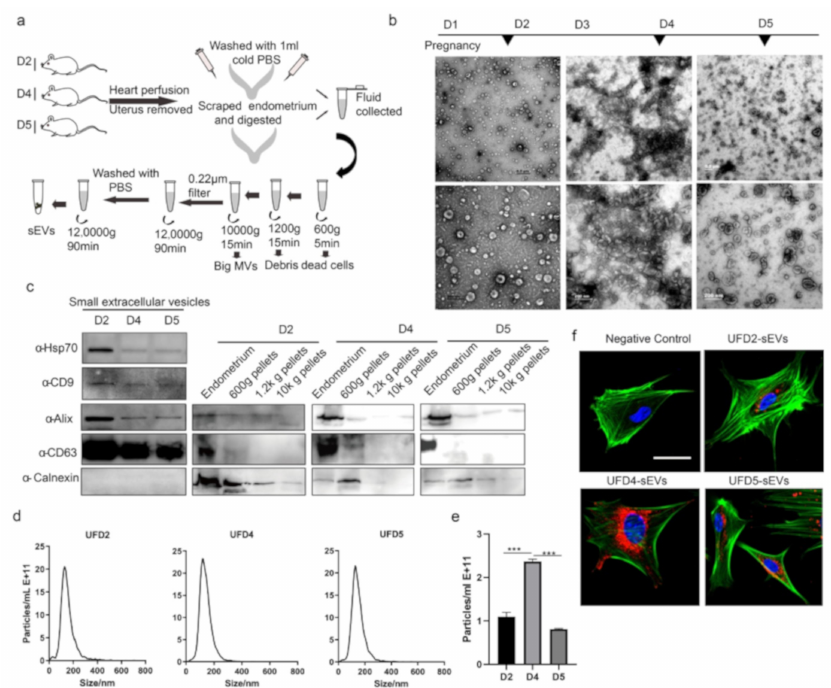
Figure 3. Identification of small extracellular vesicles (sEVs) derived from endometrium: ( a ) Schematic diagram showed the strategy of isolation and purification of sEVs derived from mouse endometrium during early pregnancy. ( b ) TEM images showed sEVs derived from mouse endometrium on D2, D4, and D5 of pregnancy. Magnification: top, 18,500. bottom, 68,000. ( c ) Western blotting analysis of sEV protein markers (CD63, Alix, CD9, and HSP70): Calnexin was used as a negative control. ( d ) Nanoparticle Tracking Analysis (NTA)-suggested size distribution and concentration of sEVs. ( e ) Concentration of sEVs derived from the uterus on D2, D4, and D5 of pregnancy. ( f ) Confocal microscopic images showed uptake of labeled sEVs by primary endometrium cells (pECs). Nuclei are stained by DAPI in blue, sEVs are stained by DiI in red, and actin is stained by FITC-conjugated phalloidin in green. (Bar 20 µ m). *** P <